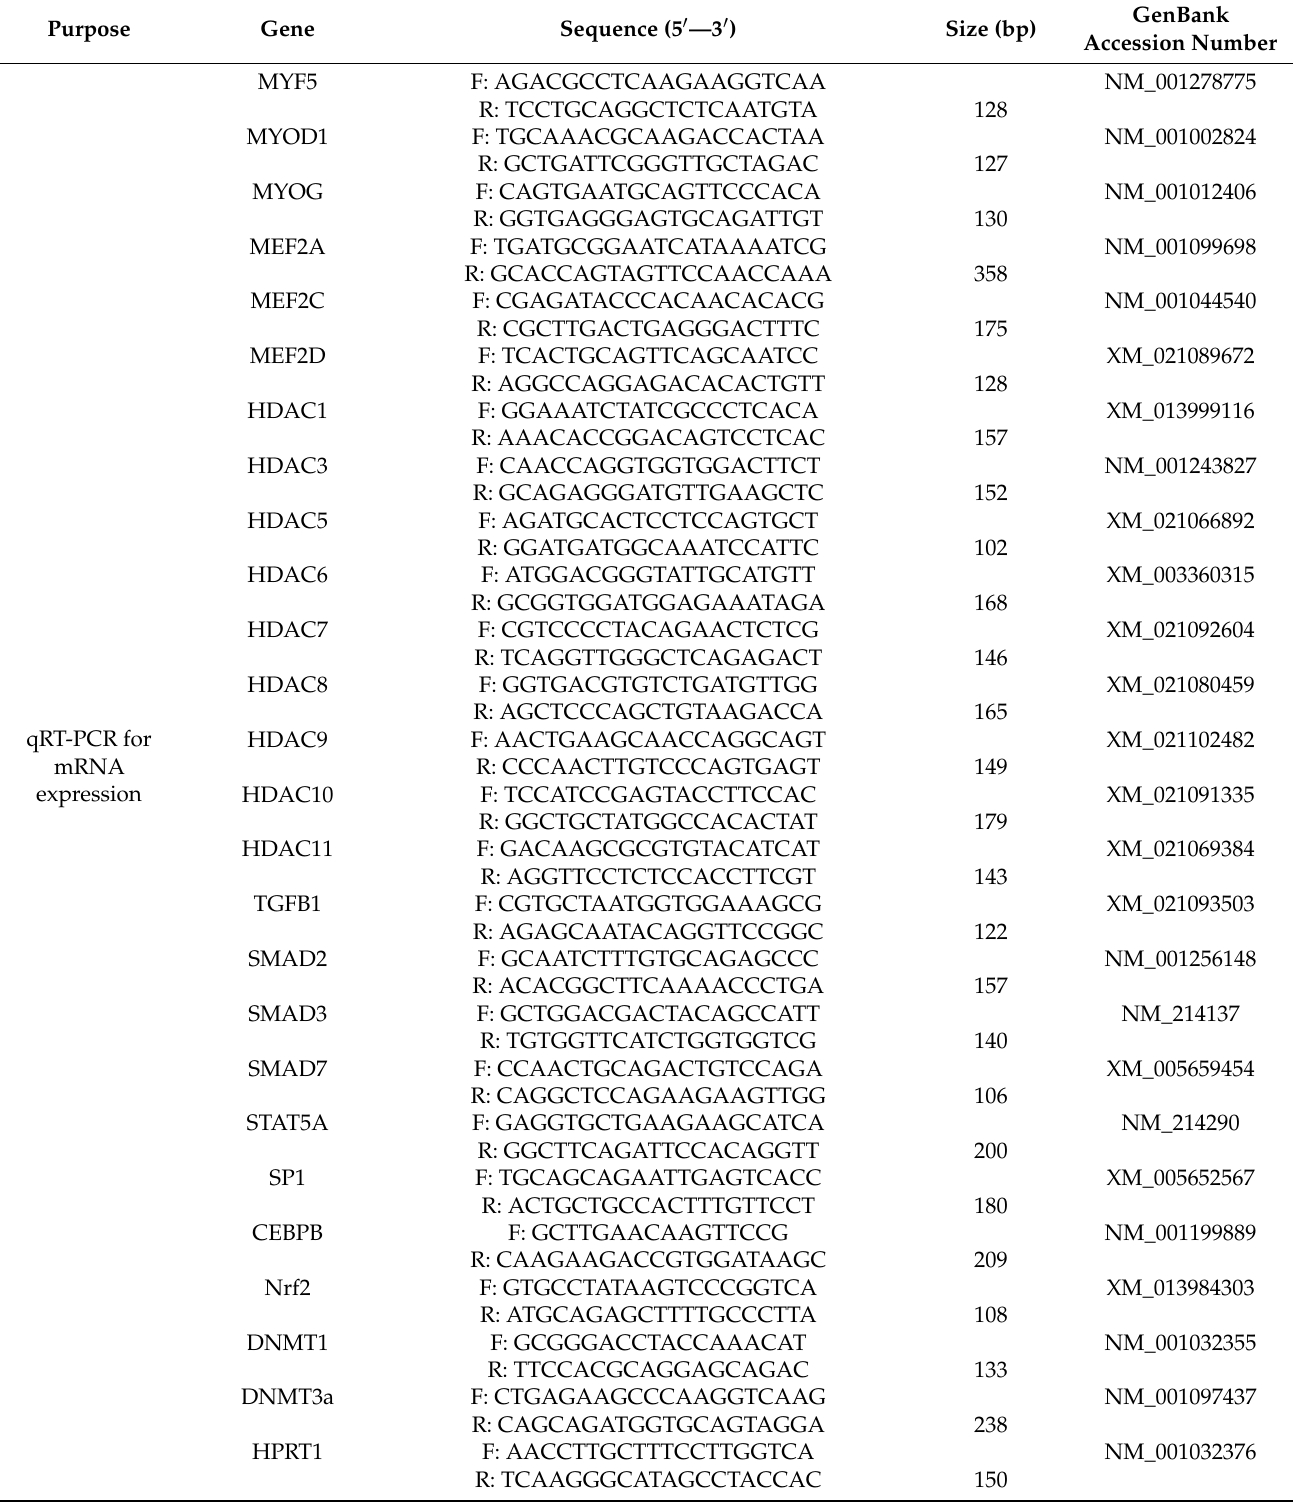
Table 1. The sequences of primers used in this